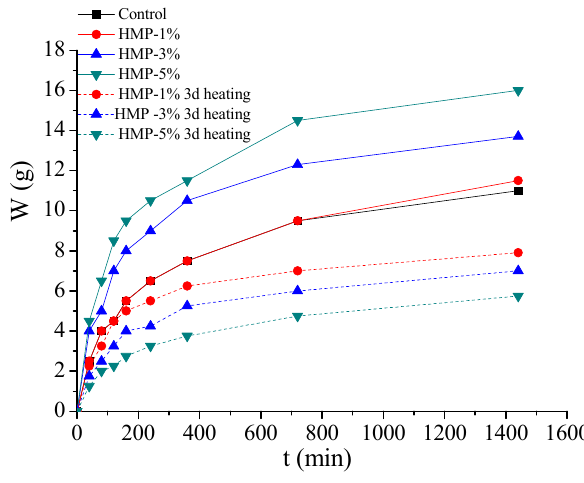
Figure 9. Water permeability results of the HMP mortars after three-day heating.